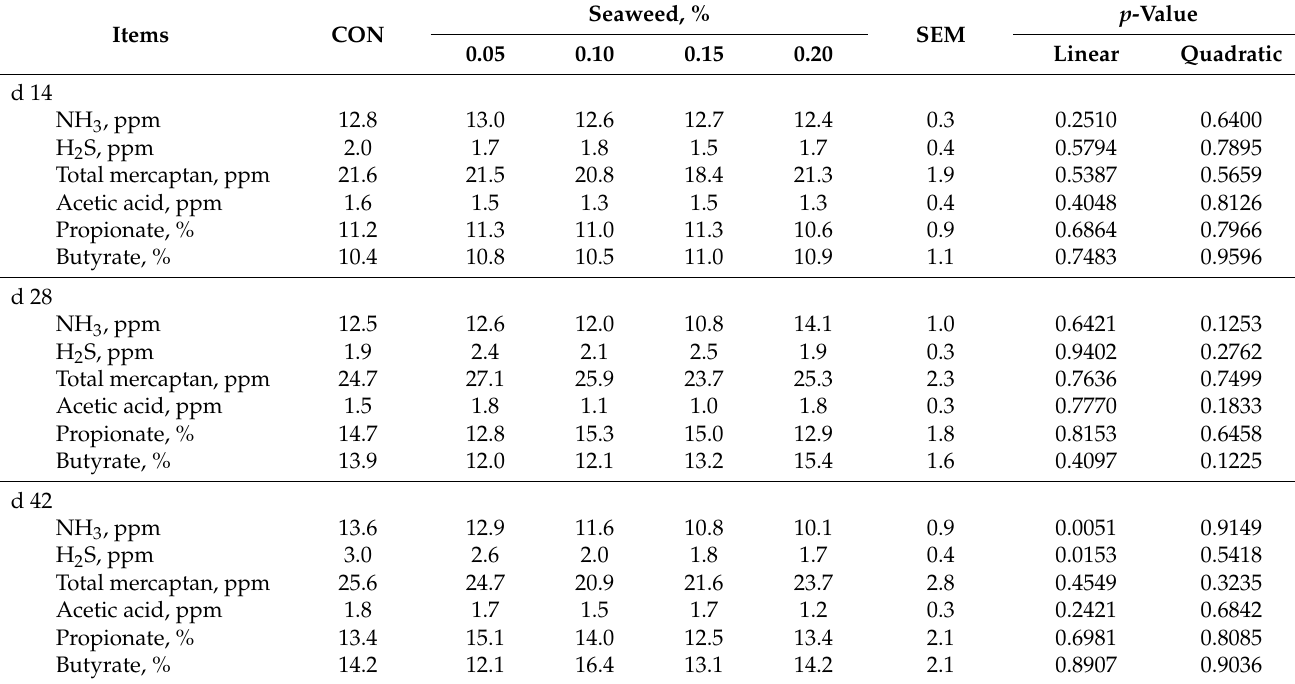
Table 7. The effect of red seaweed supplementation on gas emission in broilers 1